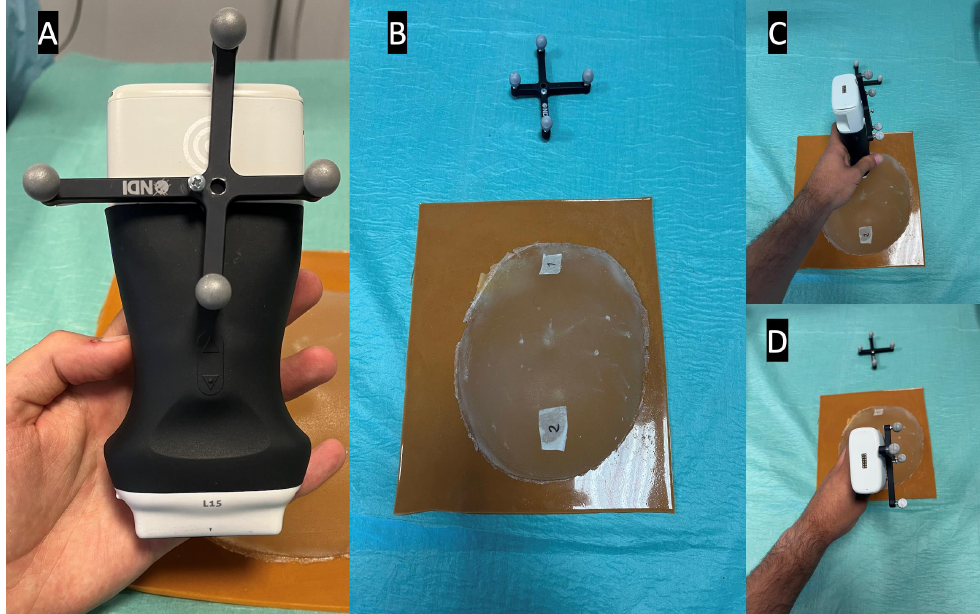
Figure 6. Latency test setup, showing in picture ( A ) the optical marker mounted on the US probe, in picture ( B ) the breast phantom with both positions marked, and in pictures ( C , D ) the US probe in its different test